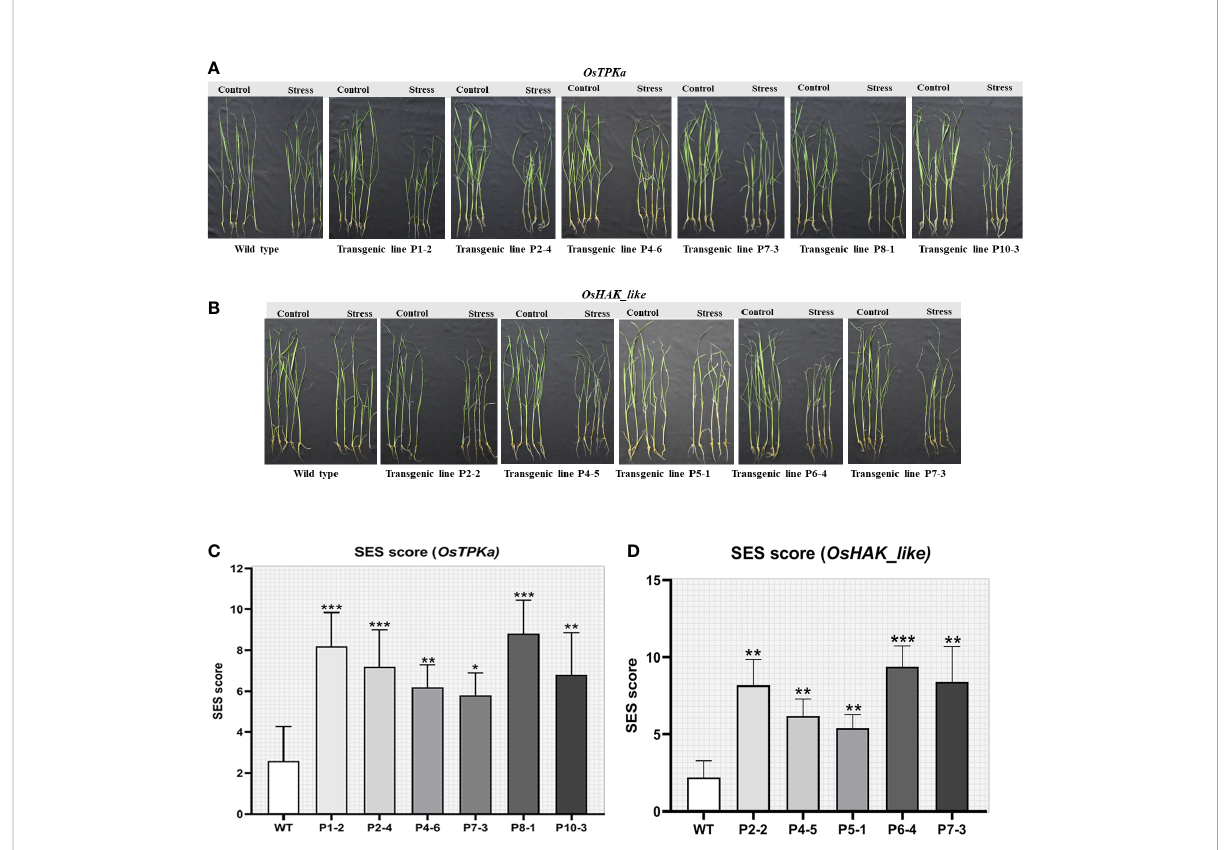
FIGURE 5 Phenotype of salt-tolerance in transformed lines. (A, B) The transformed and wild type seedlings growth at three leaf stage in hydroponics solution with 150 mM salt stress and no stress conditions for 9 days. (C, D) The comparison of seedling injury (SES score) under stress between wild type and both OsTPKa_sgRNA and OsHAK_like_sgRNA transformed plants. The stars in the graph indicates signi fi cant differences (***P < 0.001, **P < 0.01, *P < 0.1, Two way ANOVA